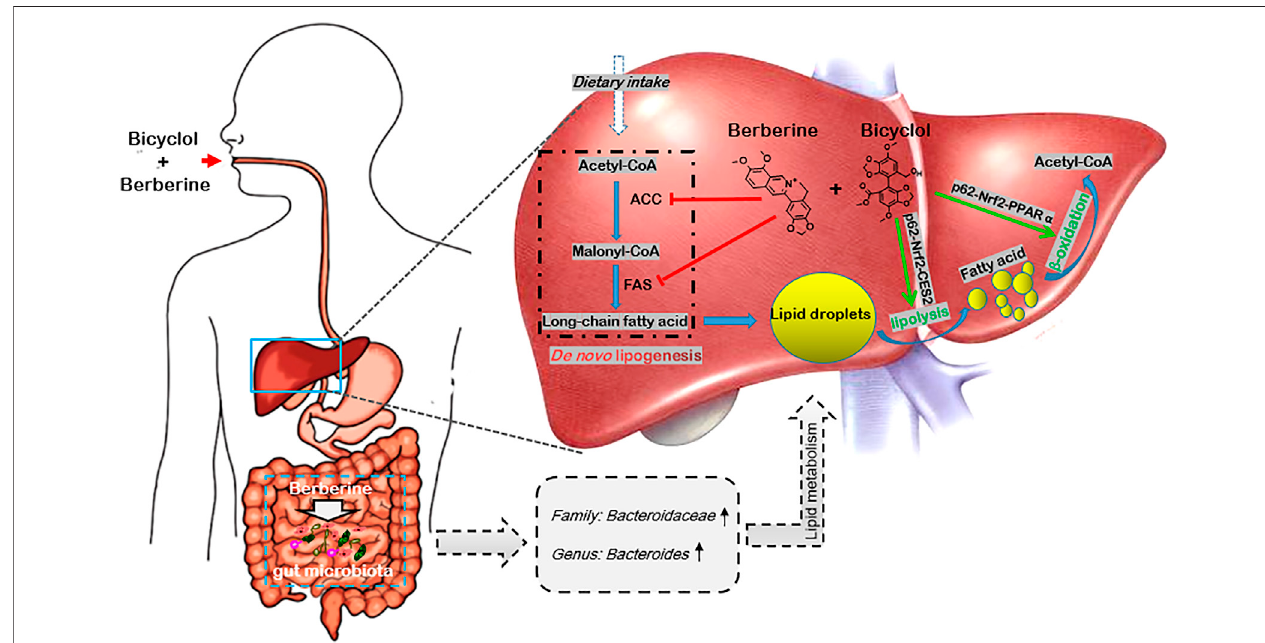
FIGURE7| Schematicdiagramofthetherapeutic mechanism ofcombineduseofbicyclol and berberineagainstNAFLD.Bicyclolenhancedlipolysisthrough p62- Nrf2-CES2 signaling axis and improved β -oxidation through p62-Nrf2-PPAR α signaling axis, while berberine suppressed the de novo lipogenesis by inhibiting protein expressions of ACC and FAS, along with the regulation of lipid metabolisms via the gut microbiota, and thus co-facilitating to ameliorate the occurrence and progress of NAFLD. The green arrow shows a stimulatory effect, the red fl athead shows an inhibitory effect.